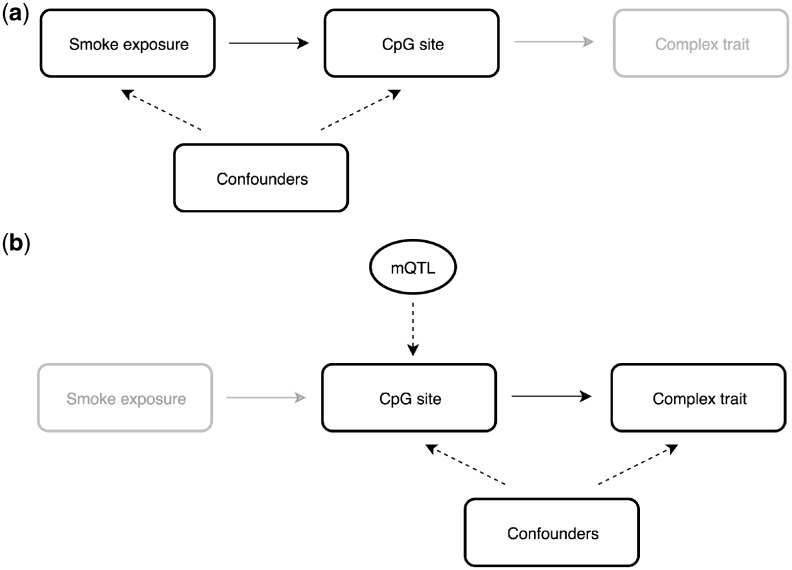
An overview of the proposed two-step epigenetic Mendelian randomization approach to evaluate findings from epigenome-wide association studies. (a) Identify CpGs sites from EWAS where a risk factor is associated with DNA methylation. Prenatal risk factors can add value as they are very unlikely to be associated due to reverse causation. (b) Use independent cis-acting methylation quantitative trait loci (mQTL) as an instrumental variable to proxy for changes in DNA methylation levels at this CpG site, allowing investigation into how these effects may influence complex traits.